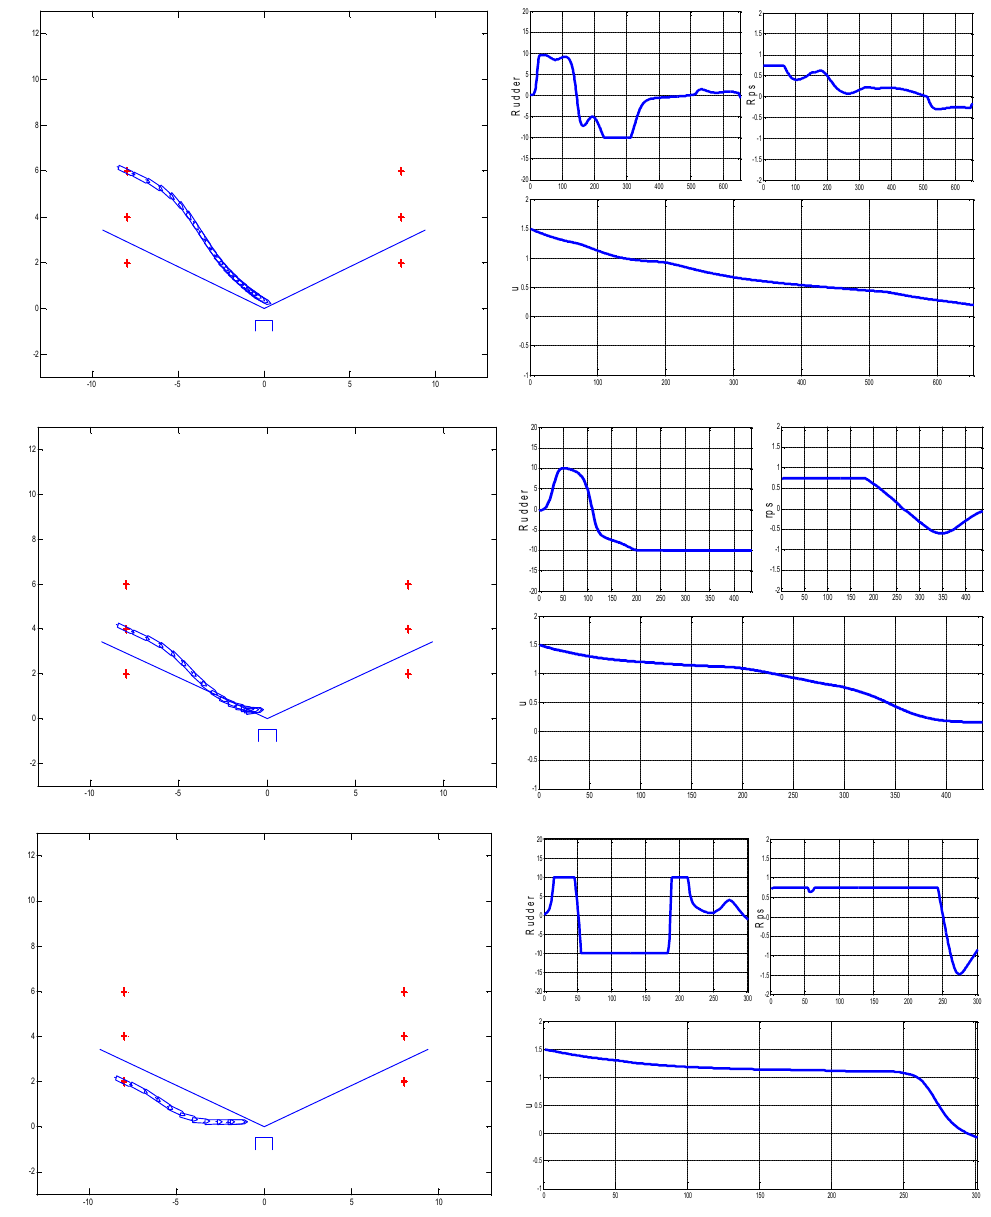
Figure 14. Automatic ship berthing in the original port from the starboard